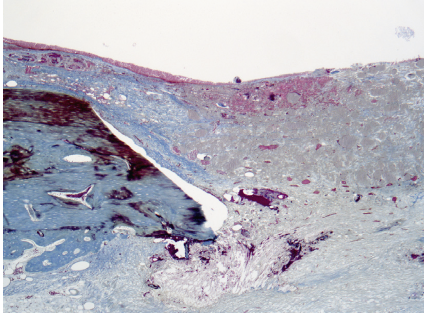
Figure 8: Histotopogram of the rabbit’s mandible cross section 2 weeks after the formation of a bone defect and introduction of a suspension of calcium hydroxide with nanodispersed cerium dioxide.